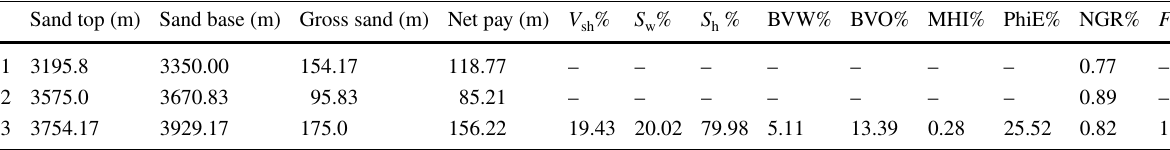
Table 3 Petrophysical properties of Well 3